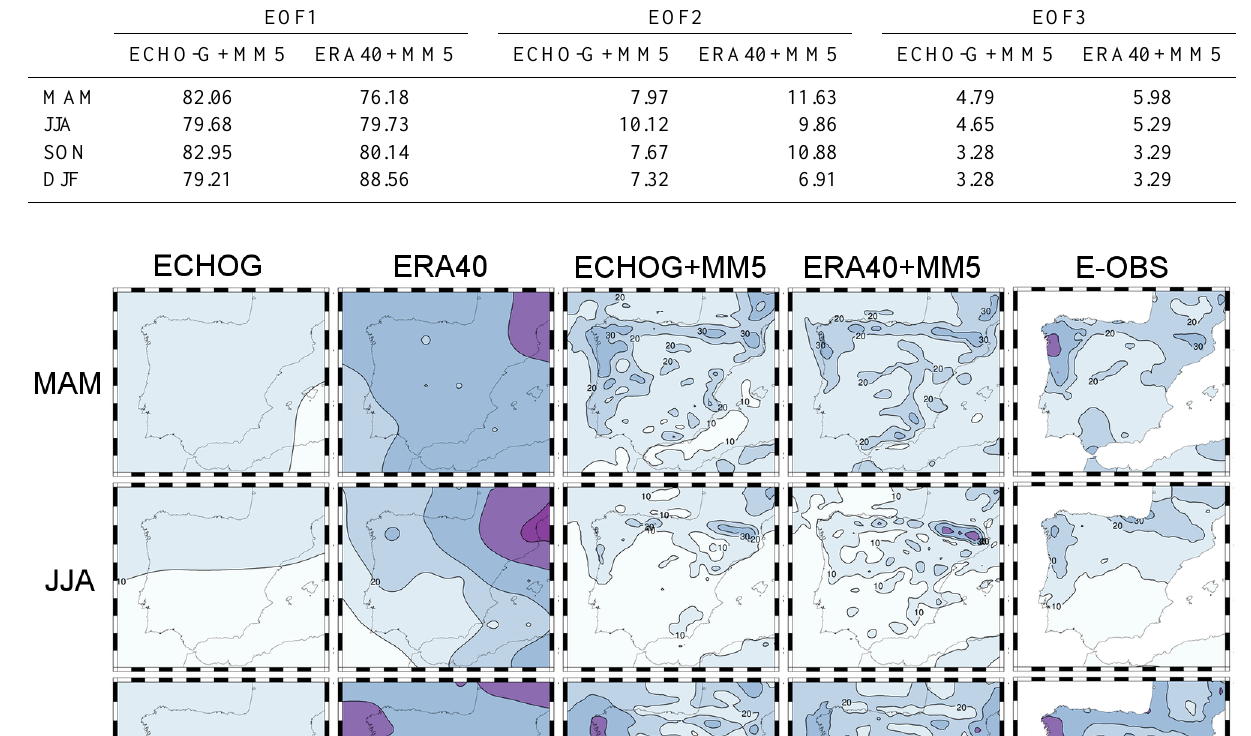
Table 1. Percentage of variance explained by each EOF of the seasonal mean series of SAT.